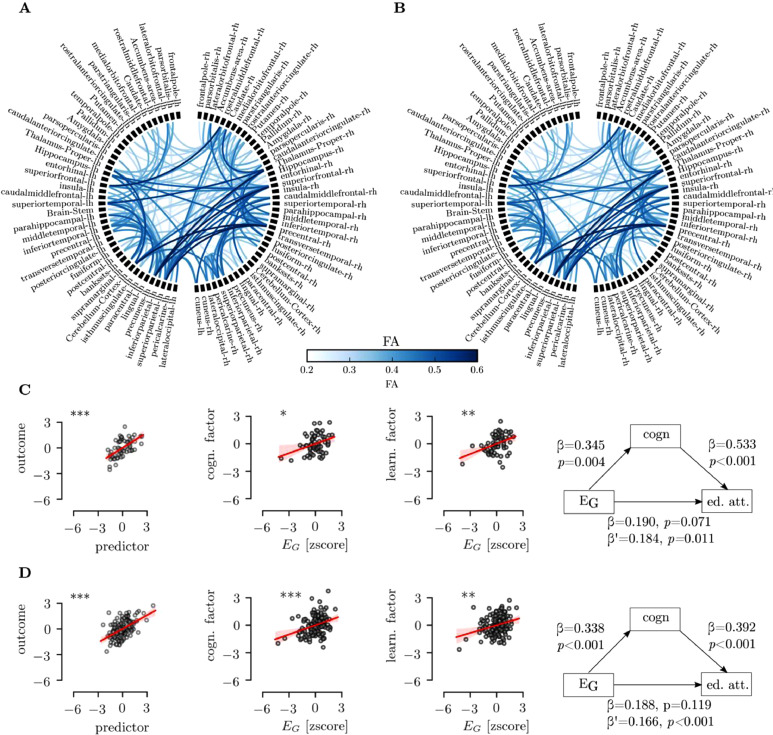
(A) Visualization of the group-average connectome in the ACE sample (B) Group-average connectome in the CALM sample. (C) Regression of factor scores for educational attainment, cognition, and global efficiency of the white matter network and mediation relationships for the ACE sample. The shaded area in the regression results shows the 5–95%ile confidence interval based on bootstrap sample with 500 permutations. (D) Regression and mediation results in the CALM sample. Legend: β: direct effect,  β’: indirect effect,  ***p<0.001, **p<0.01, *p<0.05.